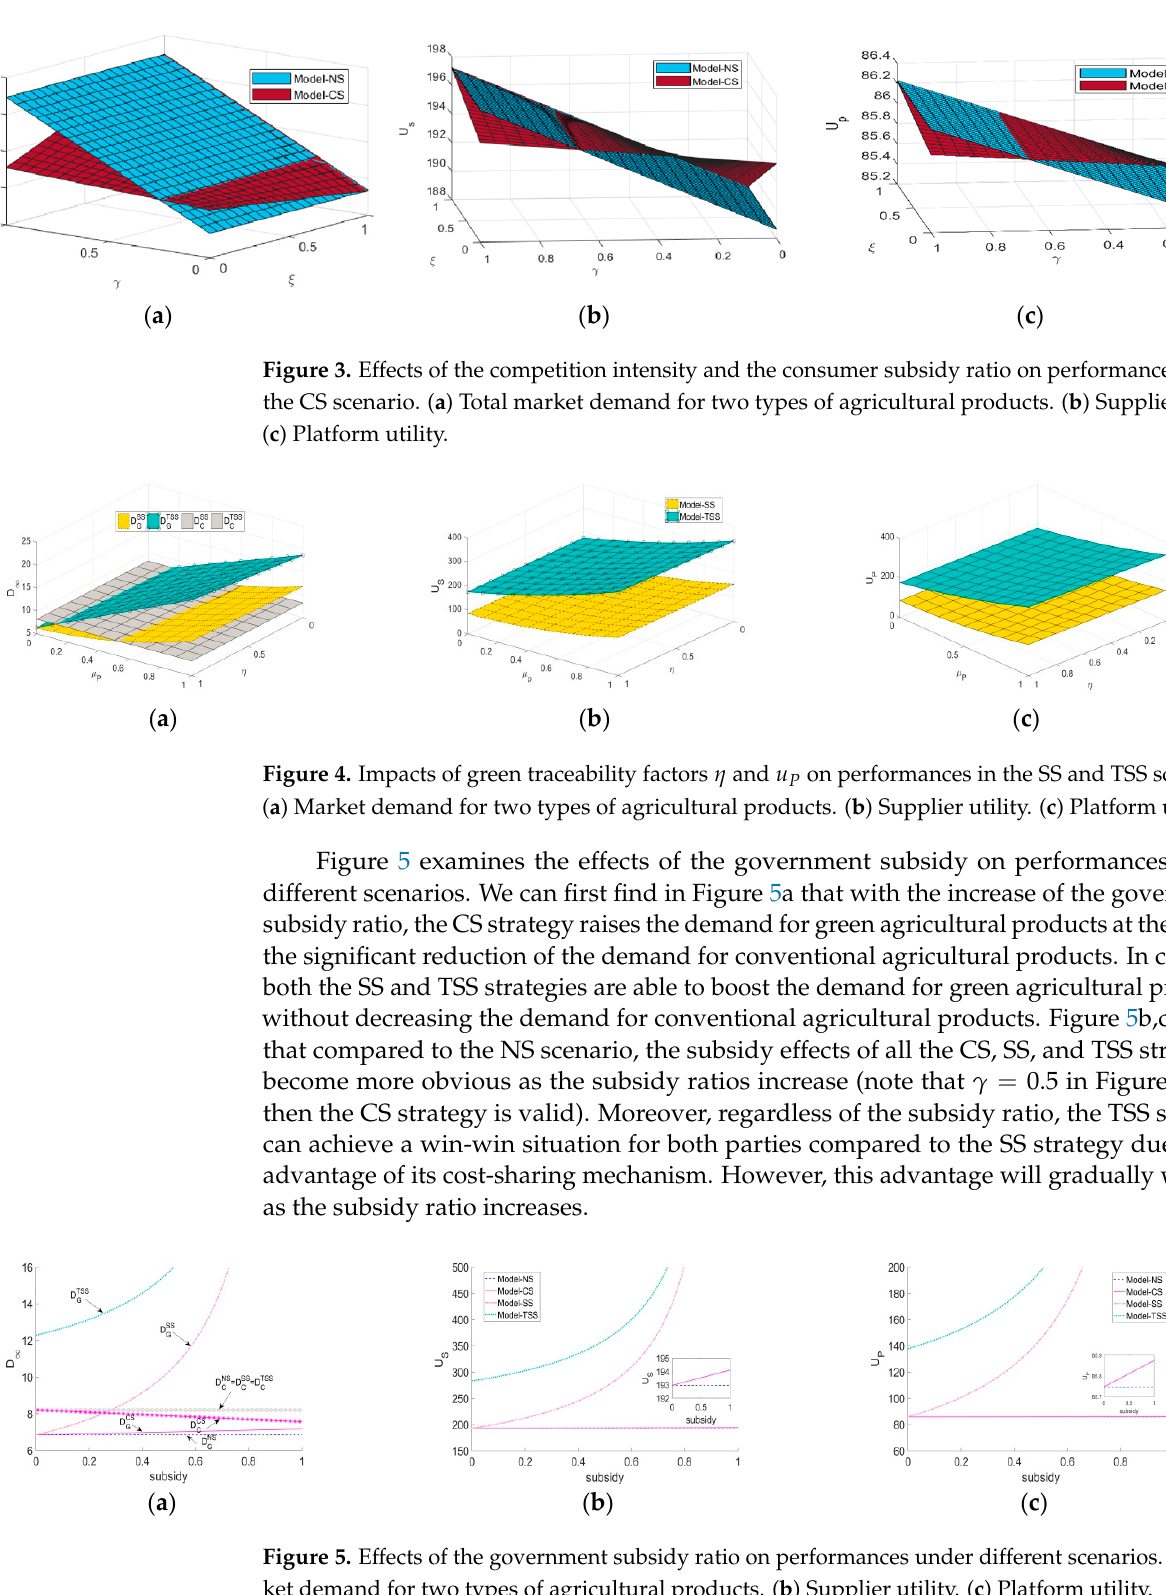
Figure 5. Effects of the government subsidy ratio on performances under different scenarios. ( a ) Market demand for two types of agricultural products. ( b ) Supplier utility. ( c ) Platform utility.